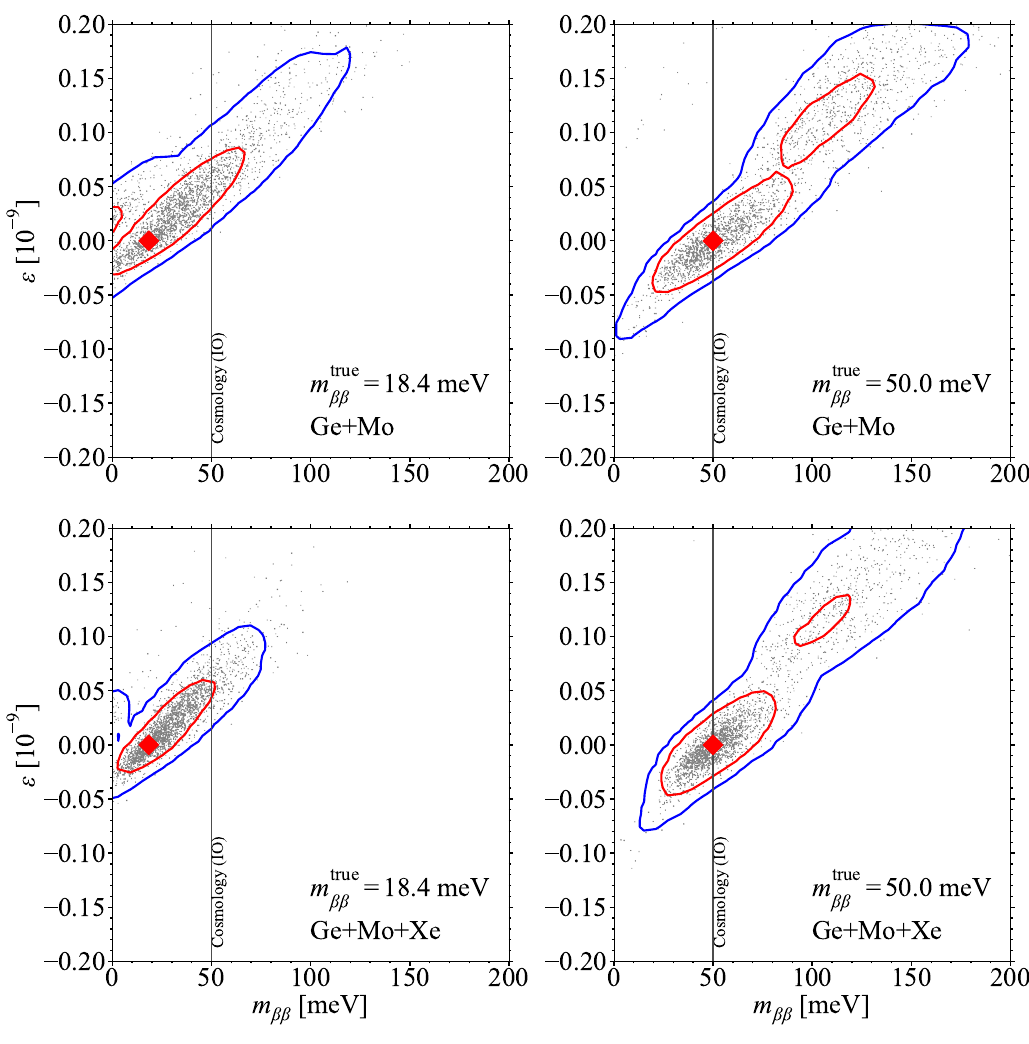
Figure 3 . Bayesian posterior probability distributions and credible regions, with current NME un- certainties, for half-life values corresponding to m ββ = 18 . 4 meV (left column) and m ββ = 50 meV (right column), and isotopes Ge+Mo (top row) and Ge+Mo+Xe (bottom row). 68% and 95% prob- ability credible regions are plotted in red and blue, respectively. The present cosmology bound on m ββ from the inverted neutrino mass ordering (IO), described in the text, is plotted as a vertical